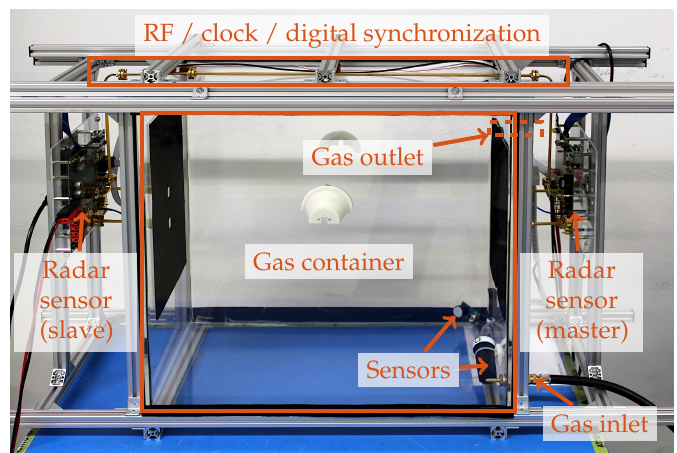
Figure 5. Photograph of the measurement setup with two synchronized low-cost radar sensors in master-slave operation mode. The synchronization link consisting of a WR-12 waveguide and multiple cables runs along the outside of the gas container. Multiple sensors for concentration, pressure, temperature and humidity are visible inside the box. The inclusion gas source is connected to the bottom inlet, the gas outlet on top is hidden by the mechanical support